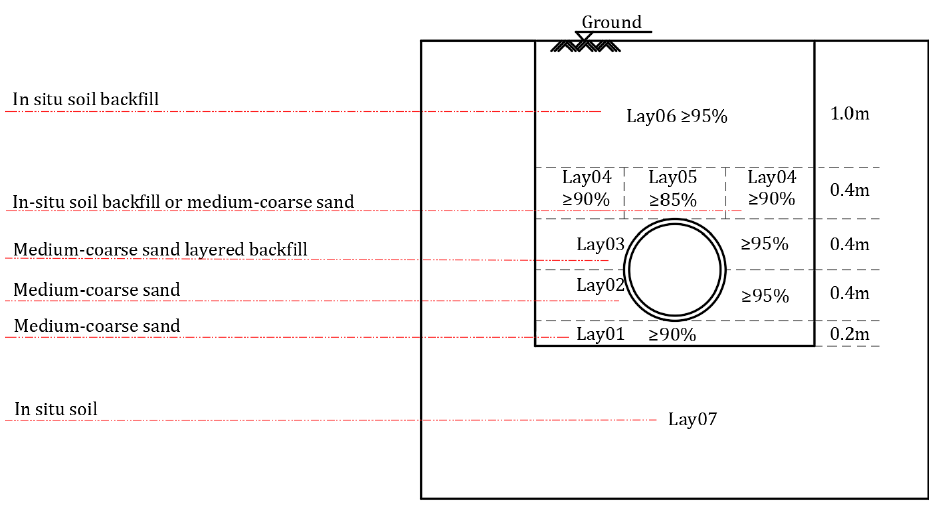
Figure 8. Thickness and compaction of each soil layer.